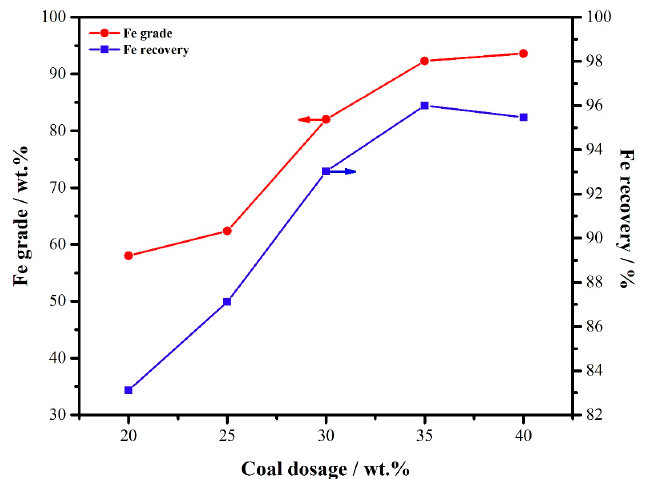
Figure 8. The effects of coal dosage on the Fe grade and recovery. Figure 8. The e ff ects of coal dosage on the Fe grade and